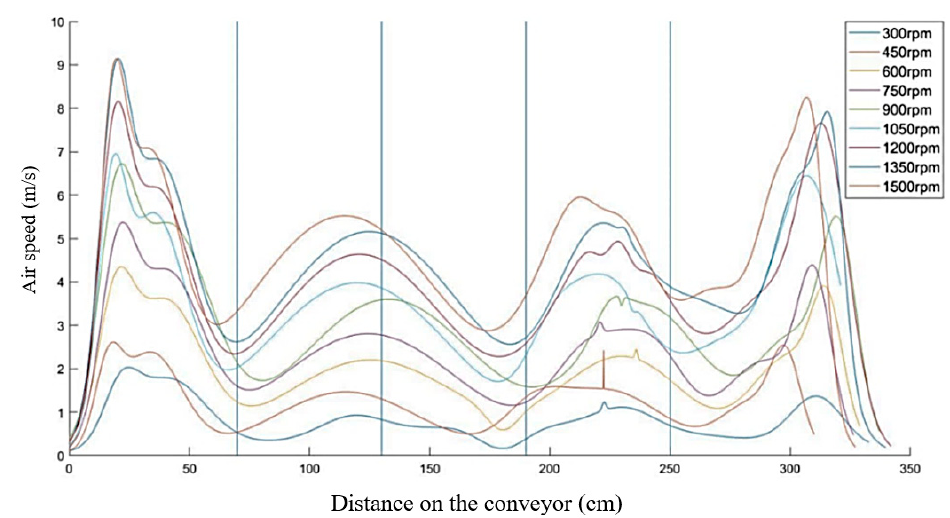
Figure 17. Distribution of the air flow speed in the scope of 300–1500 rpm along the conveyor belt shift axis (axis X); vertical lines: ventilators axes.